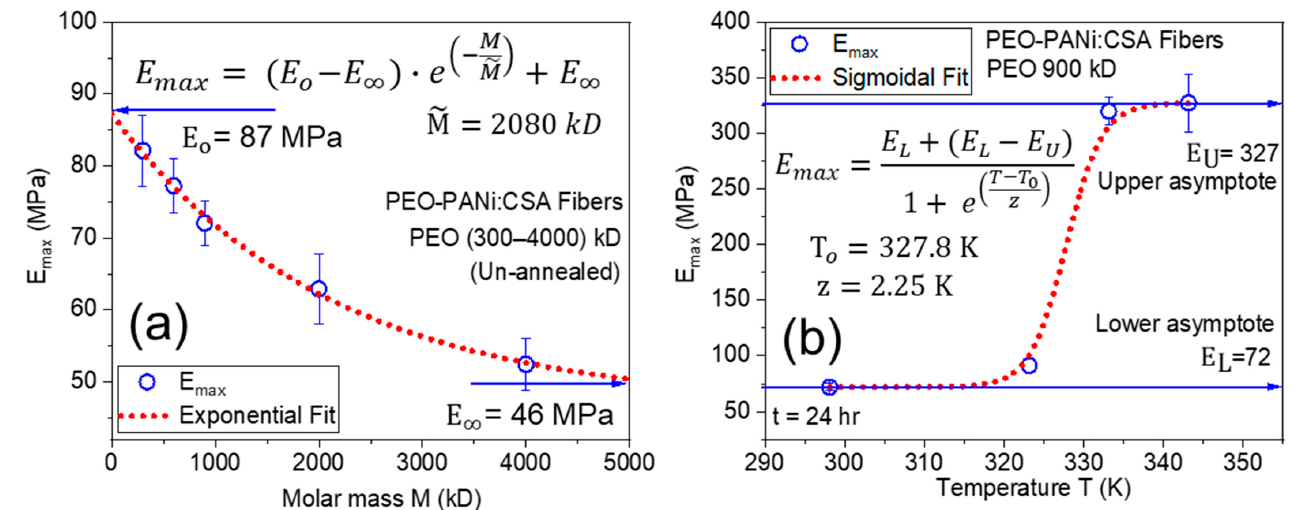
Figure 9. Panel ( a ) shows a negative exponential correlation between maximum Young’s modulus ( E max ) and molar mass ( M ) with E o = 87 MPa (at M → 0), E ∞ = 46 Mpa (at M → ∞ ) and characteristic molar mass 𝑀(cid:3561) . Panel ( b ) shows the sigmoidal fit function between E max and temperature T with lower (E L = 72 MPa) and upper (E U = 327 MPa) asymptotes, while T o is the characteristic value of temperature and z describes the slope of fit function.